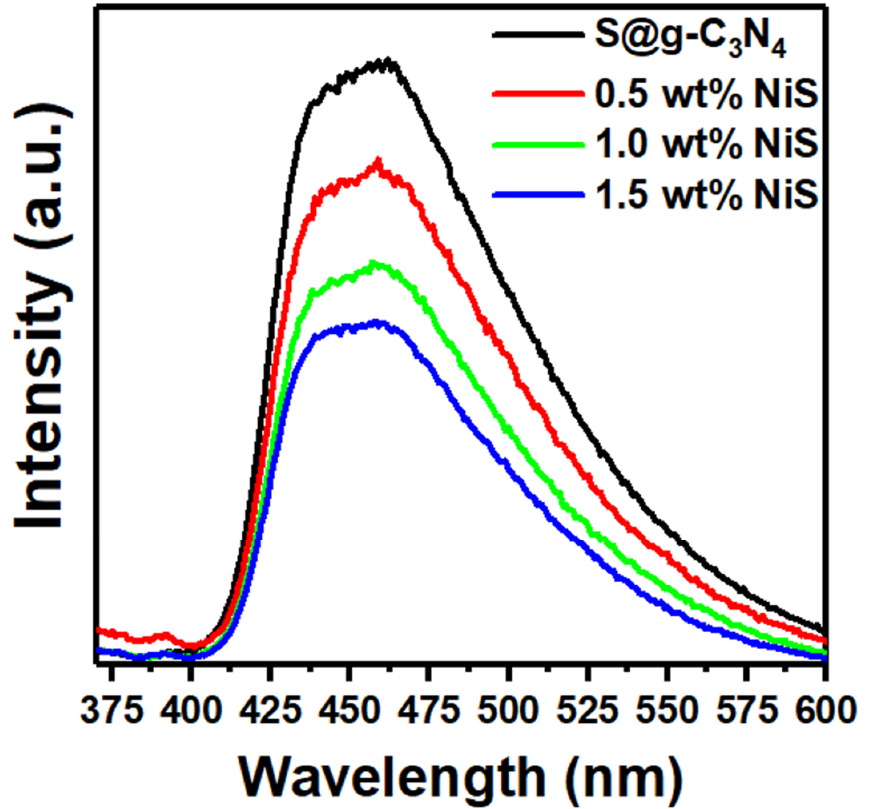
Figure 7. PL spectra for S@g-C 3 N 4 and NiS-g-C 3 N 4 nanocomposites.